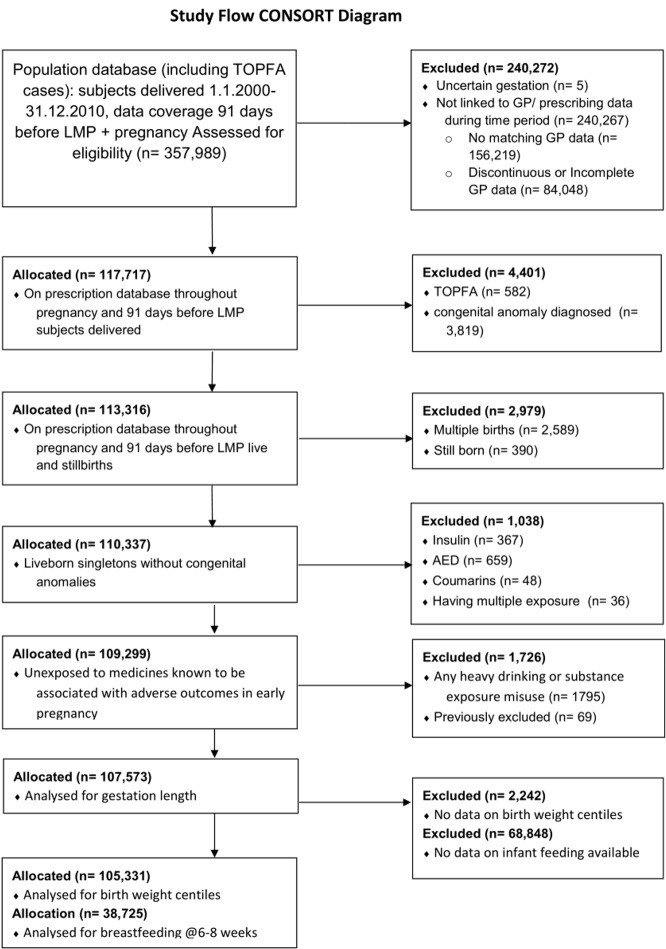
Study flow diagram.